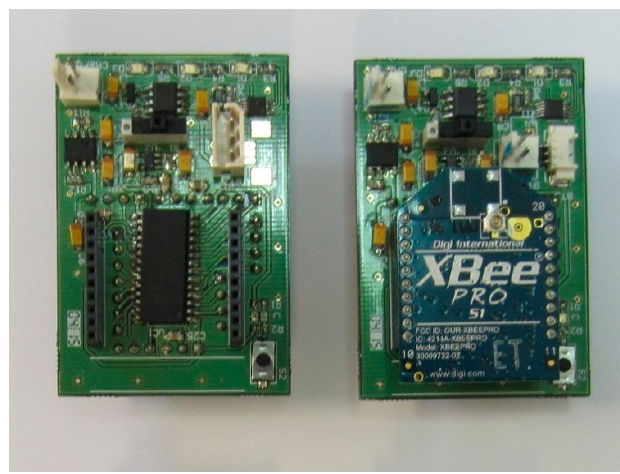
Figure 2. Wearable sensor node photograph: ( Left ) without XBee; ( Right ) with XBee.